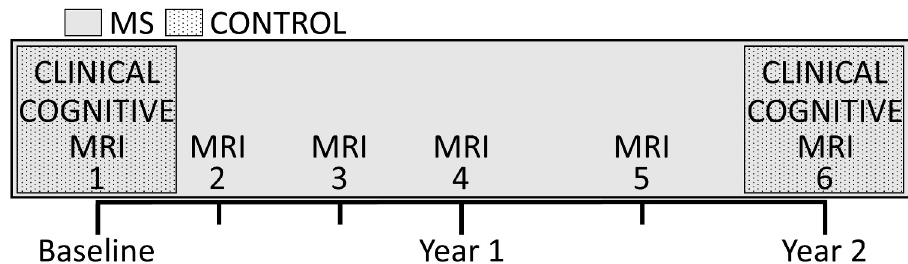
Fig 1. Schematic of study visits. MS = Multiple Sclerosis.